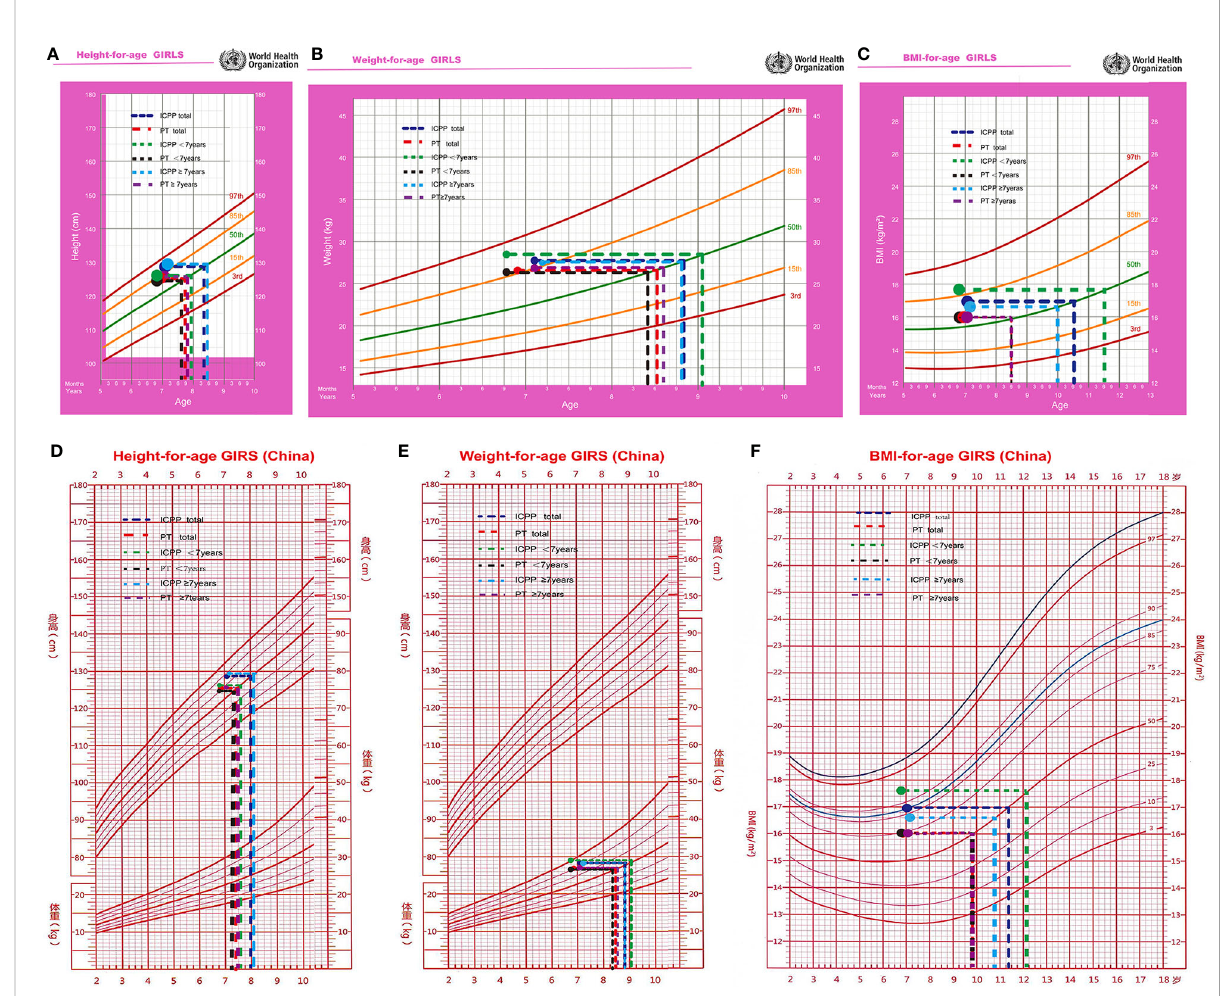
FIGURE 3 The height (A, D) , weight (B, E) , and BMI (C, F) were equivalent to normal girl's age at initial